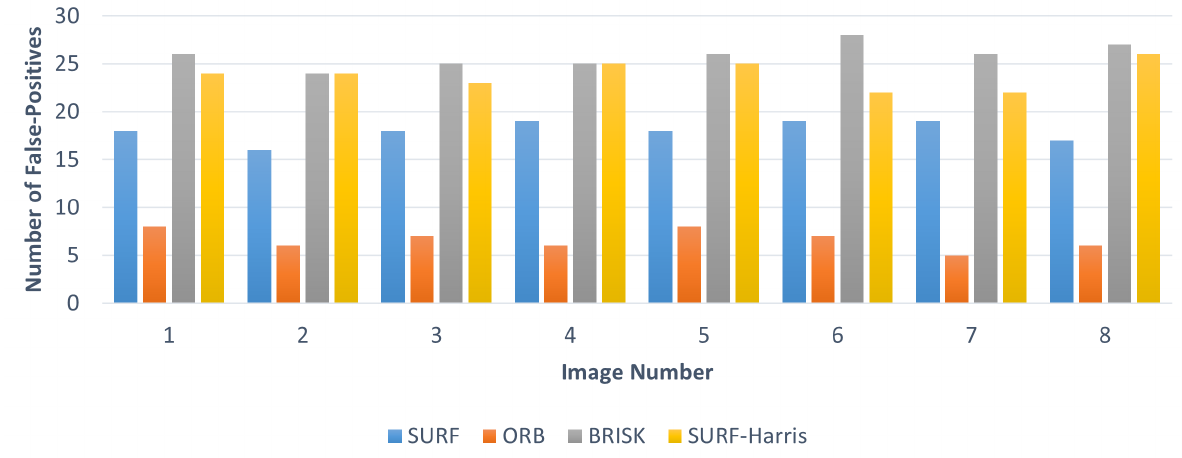
Figure 24. Number of false-positives detected amongst the 50 best interest points detected in each image of dataset 1 employing the selection module.